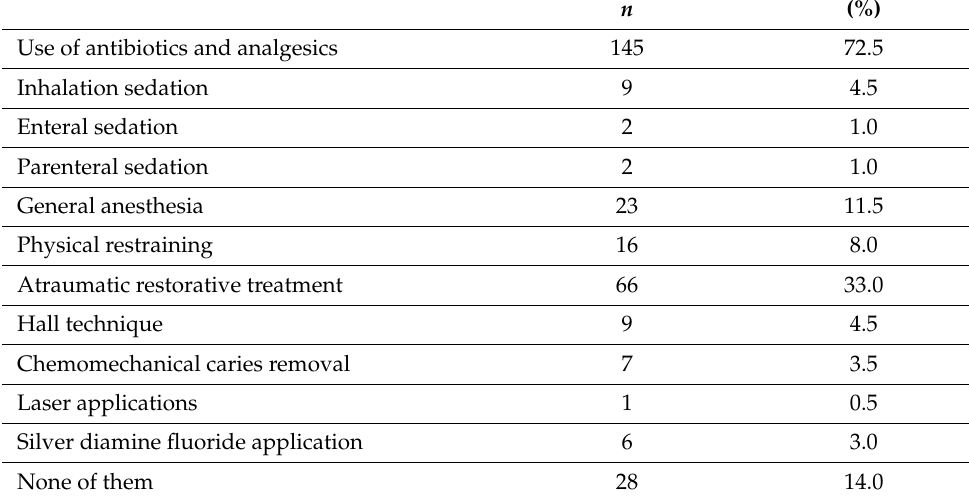
Table 11. Participants’ practice measures used with children who were not cooperative with non- pharmacological behavior management techniques during the COVID-19 pandemic period.